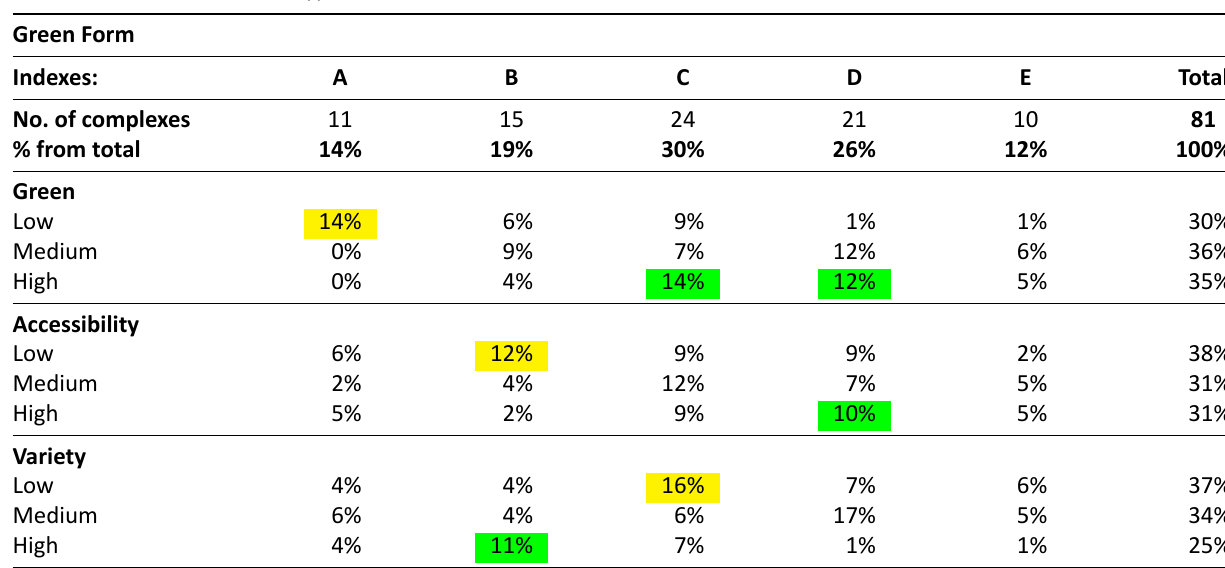
Table 2. Indexes and HRHCs